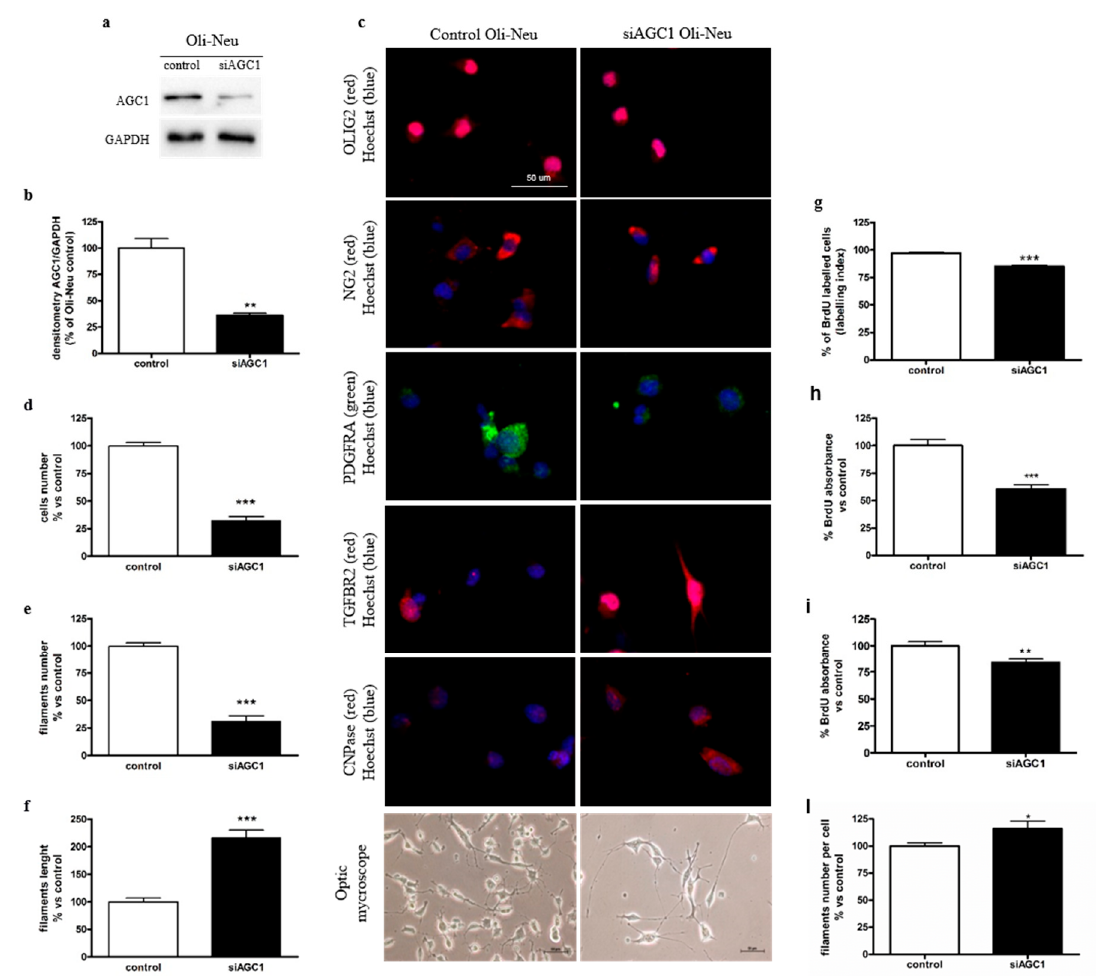
Figure 1. Spontaneous oligodendrocyte precursor cell (OPC) differentiation and OPC proliferation defects in aspartate glutamate carrier 1 (AGC1)-silenced Oli-Neu cells. Western blot analysis ( a ) and relative densitometries ( b ) of AGC1 expression in Oli-Neu cells, in which a partial silencing of the mouse AGC1 gene has been produced (siAGC1). Densitometry is the ratio between the expression level of AGC1 and GAPDH (Glyceraldehyde 3-phosphate dehydrogenase) as reference loading control and is expressed as percentage vs control Oli-Neu cells. Immunofluorescence staining and optical microscopy images ( c ) of control and siAGC1 Oli-Neu cells. Nuclei were labelled with Hoechst, while Olig2, NG2, PDGF α R, TGF β R2 and CNPase were used as specific markers for Oli-Neu cells. Analyses for cells number ( d ), total filaments number ( e ), filaments length ( f ) and filaments number per cell (l) calculated with Fiji ImageJ2 software. Scale bar: 50 µ m. BrdU immunofluorescence of control and siAGC1 Oli-Neu cells with nuclei staining with Hoechst (blue) and BrdU positive-cell count analysis expressed as labelling index ( g ). BrdU incorporation by ELISA assay (enzyme-linked immunosorbent assay) in control and siAGC1 Oli-Neu cells after 6 ( h ) and 24 h ( i ) BrdU incubation. Scale bar: 100 µ m. Values are the mean ± SE of 3 independent experiments performed in triplicate, * p < 0.05, ** p < 0.01, *** p < 0.001 compared to control Oli-Neu cells, Student’s t -test.